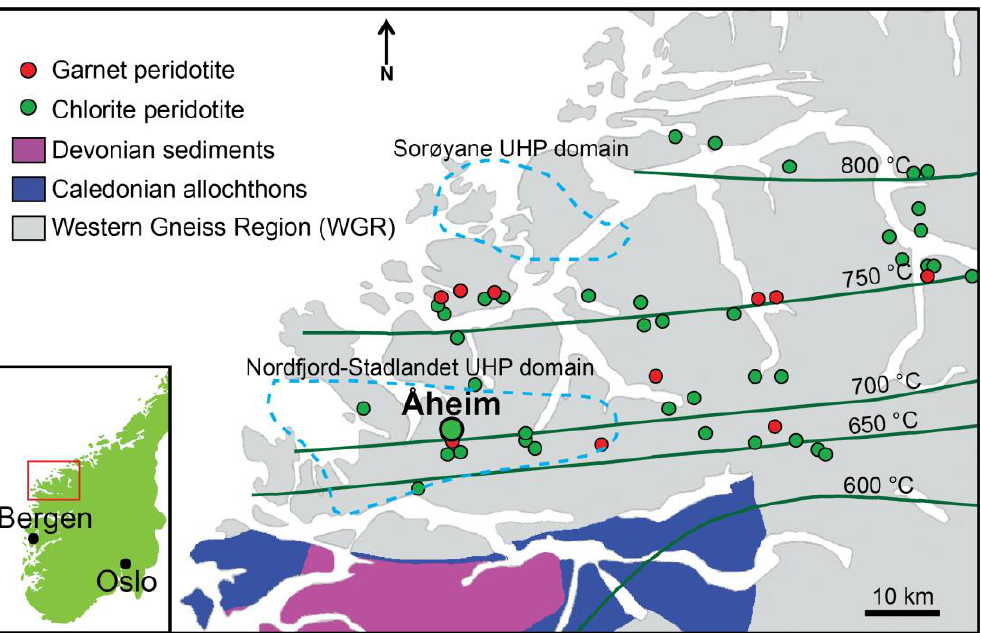
Figure 1. Simplified geological map and the distribution of peridotite bodies in the Western Gneiss Region, Norway (modified after Austrheim [47], Brueckner etl al. [53], Root et al. [63], and Wang et al. [16]). Samples are from Gusdal quarry in Åheim (larger green circle). The green lines indicate the approximate peak metamorphic temperature [57]. Locations of chlorite peridotite and a garnet peridotite body are marked with a green and red circle, respectively. Two UHP domains, Nordfjord-Stadlandet and Sorøyane, are marked by a dotted blue line.